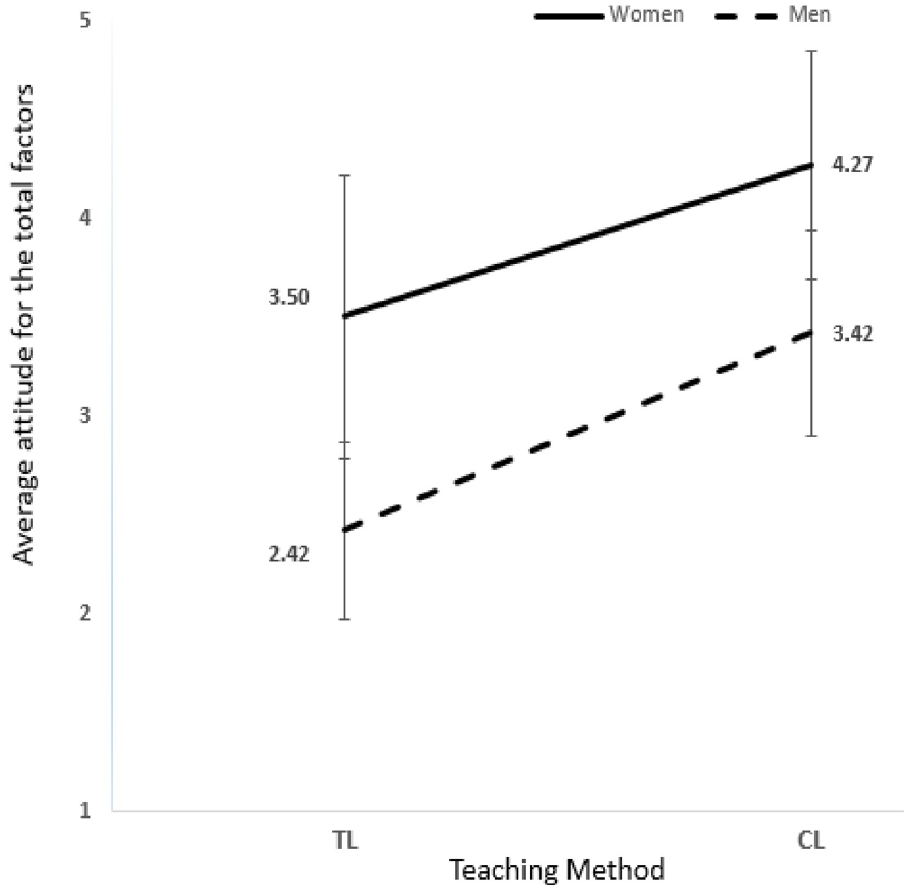
Fig 5. Nonmajor single-gender: Present the total nine attitude factors mean and SD for nonmajor single-gender students.